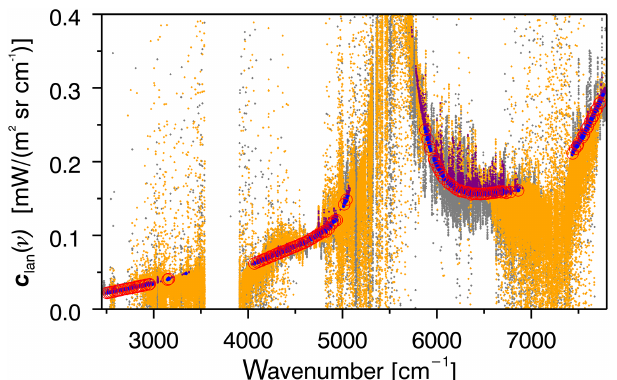
Figure 3. Selection of suitable spectral points and averaging for Langley calibration (measurements from 13 December 2013). Grey: initial Langley fit results; orange: results not affected by solar lines; purple: results after applying fit uncertainty threshold; blue: final results after applying stability threshold; red circles: Langley cali- bration results averaged over 20cm − 1